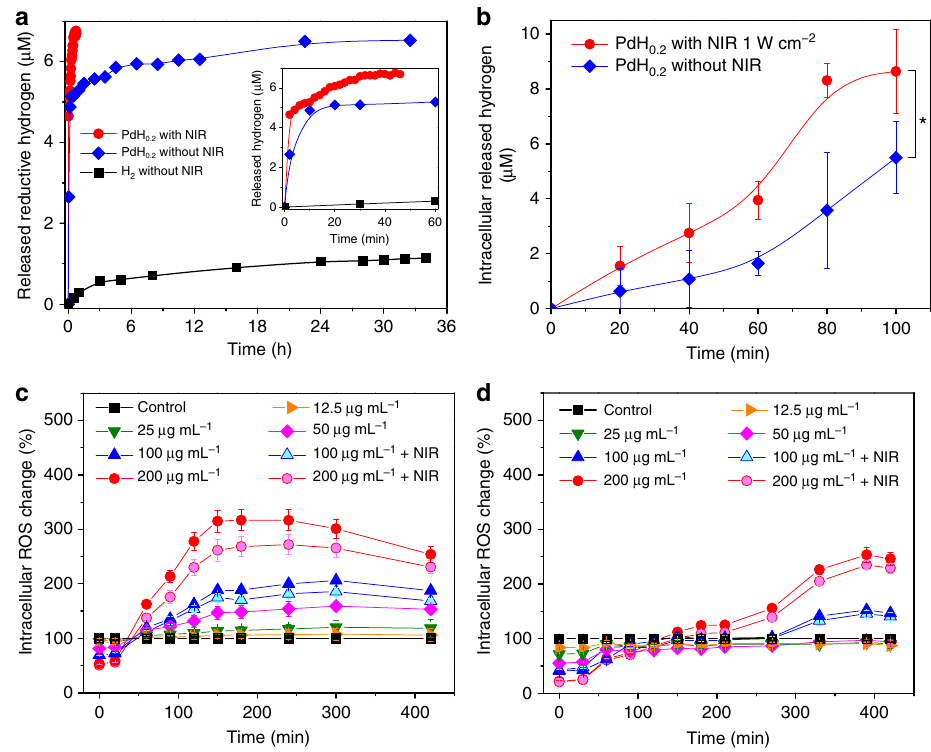
Fig. 3 NIR-enhanced reduction capability of active hydrogen released from PdH 0.2 nanocrystals. a , b Hydrogen release in stimulated body fl uid ( a ) and in HeLa cells ( b ), which was detected using MB as an oxidative probe for active hydrogen. P values were calculated by two-tailed Student ’ s t -test ( *P < 0.05). c , d The effect of PdH 0.2 nanocrystals on intracellular ROS levels in cancer (HeLa cells, c ) and normal (HEK-293T cells, d ) cell models in the presence and absence of NIR irradiation ( n = 6). In a , the treatment of MB with the H 2 -rich water was used as the blank control without PdH 0.2 and NIR irradiation. Mean value and error bar are de fi ned as mean and s.d.,